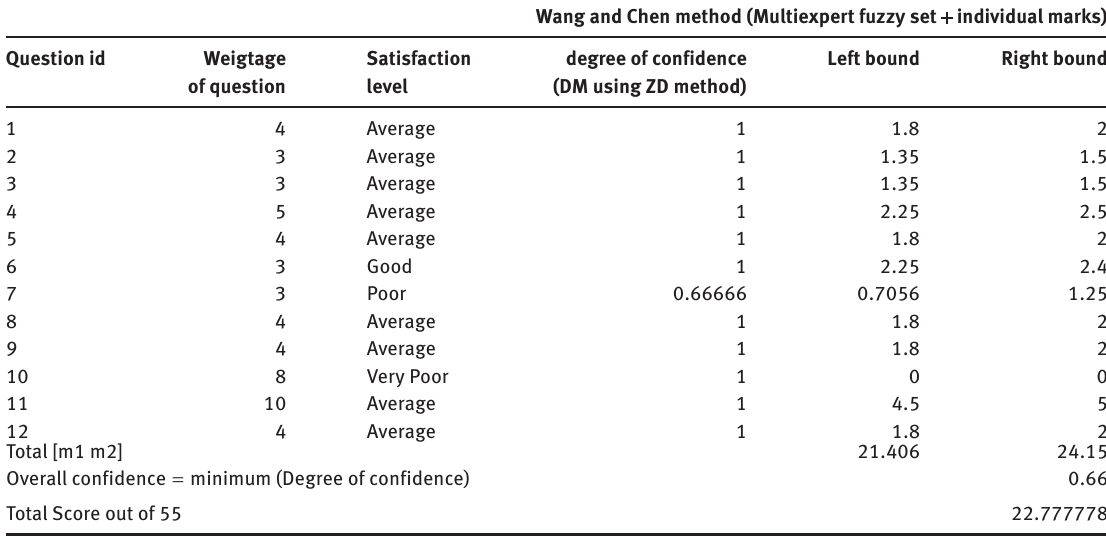
Table 11: Evaluation Sheet of Student ID-02’s Answer Script by Teacher ID-04 Using the Wang and Chen Method. Wang and Chen method (Multiexpert fuzzy set + individual